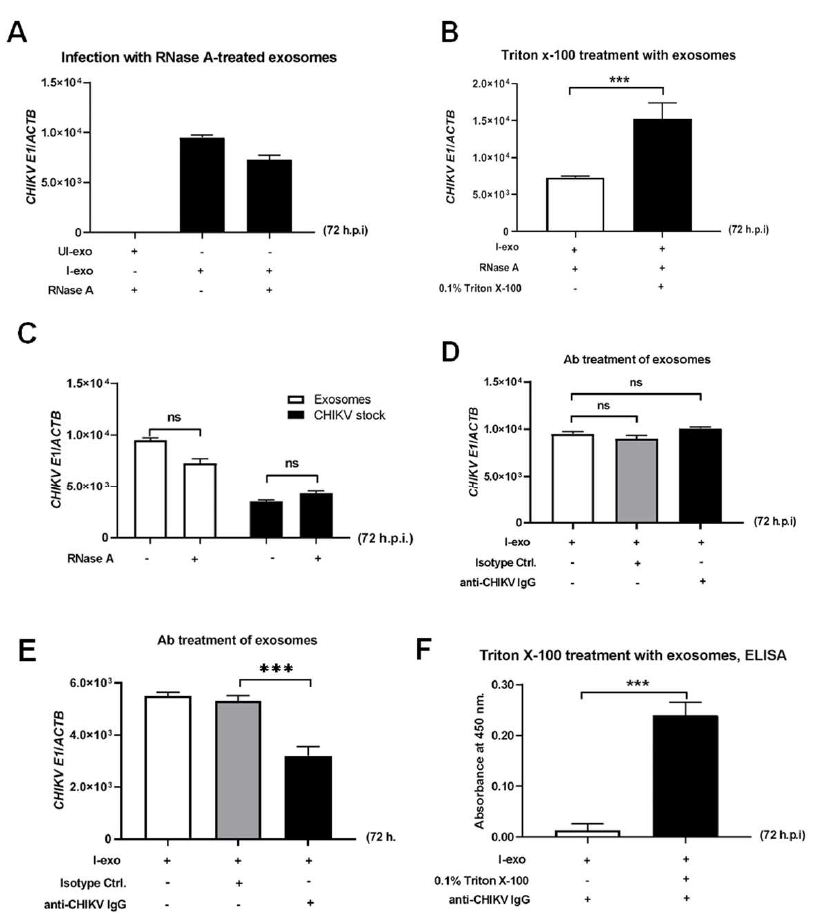
Figure 4. CHIKV RNA and proteins are securely contained inside small EVs. ( A ) qRT−PCR analysis representing CHIKV loads in naïve Vero cells that were incubated with exosomes derived from 5 MOI CHIKV accompanied by the RNase A treatment. Uninfected treated cells were used as control. ( B ) Relative qRT−PCR measurements from the exosomes fraction derived from 5 MOI CHIKV−in- fected Vero cells at 72 h.p.i. accompanied by the RNase A treatment with 0.1% Triton X−100 was demonstrated. The untreated group served as a control. ( C ) qRT−PCR analysis exhibiting CHIKV loads in naïve Vero cells infected via either infectious exosomes derived from 5 MOI CHIKV−in- fected Vero cells at 72 h.p.i. or 5 MOI of CHIKV laboratory viral stocks accompanied by the RNase A treatment. The untreated group served as a control. ( D , E ) qRT−PCR analysis revealed viral loads in exosomes derived from 5 MOI CHIKV−infected Vero cells at 72 h.p.i. ( D ) or 5 MOI of CHIKV laboratory viral stocks ( E ) that were treated with anti−CHIKV IgG from patient plasma or the matched isotype−control. Untreated exosome samples were used as the based-line control; ns indi- cates not significant. ( F ) ELISA assay representing the increased detection of CHIKV−derived pro- teins from exosomes isolated from 5 MOI CHIKV-infected Vero cells at 72 h.p.i. when treated with 0.1% Triton X−100 in comparison to untreated control; *** , p < 0.0001.